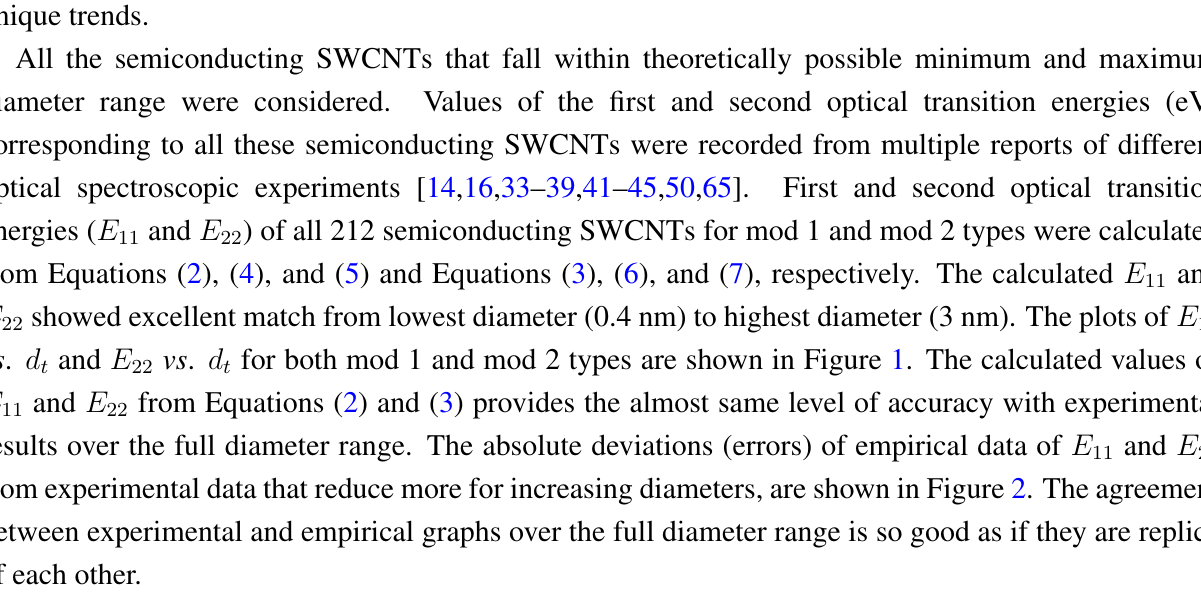
Figure 1. Plot of first ( E ) and second ( E ) optical transition energy vs . nanotube diameter 11 22 ( d ). ( a ) Comparing experimental and empirical E for mod 1; ( b ) Comparing experimental t 11 and empirical E for mod 2; ( c ) Comparing experimental and empirical E 11 ( d ) Comparing experimental and empirical E for mod 22